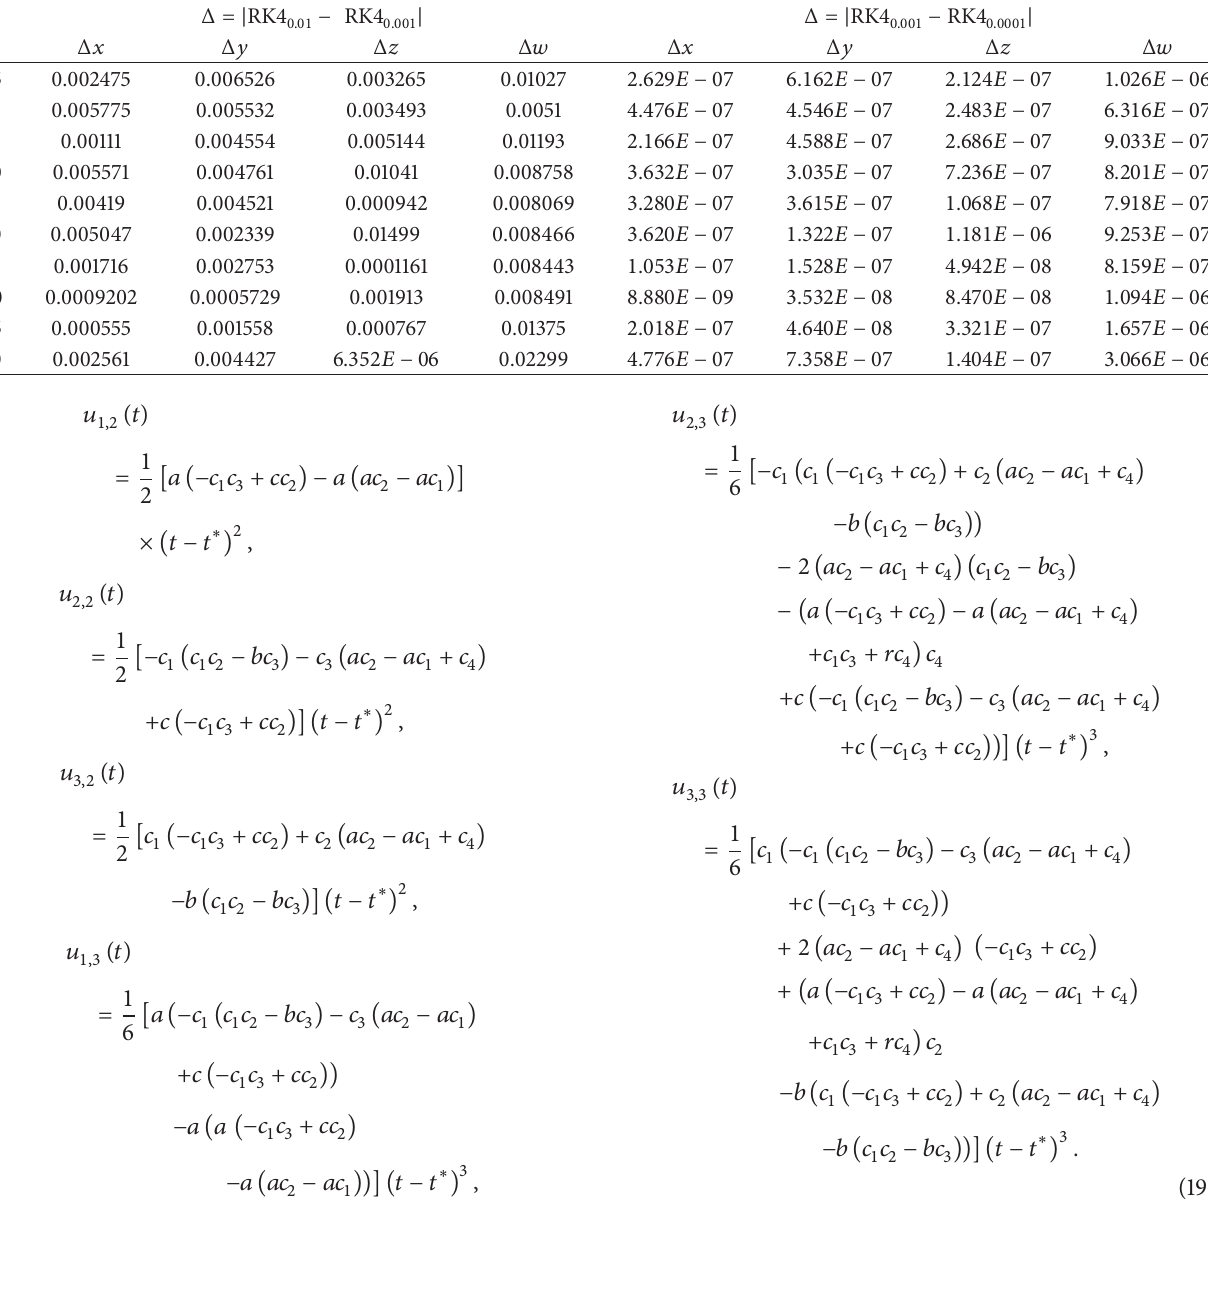
Table 4: Determination of accuracy of RK4 for hyperchaotic L¨u system for Case 3